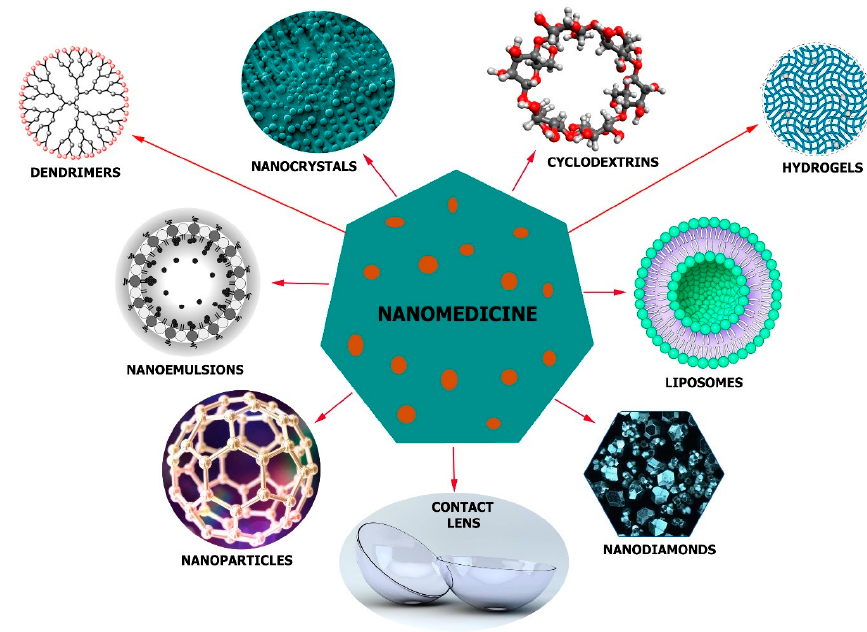
Figure 4. A scheme showing the structures of some nano-formulations used in glaucoma treatment: Nanoparticles with the ability to pass through biological barriers, nanoemulsions with increased drug solubility and membrane penetration, nanodiamonds with accessible surface area and tailorable surface chemistry, hydrogels, and nanocrystals for the conveyance of poorly water-soluble medicines, dendrimers, and liposomes capable of carrying hydrophobic and hydrophilic medicines, contact lens capable enzyme triggered release and cyclodextrins with the ability to form inclusion complexes enclose the lipophilic drug without changing its molecular structure.